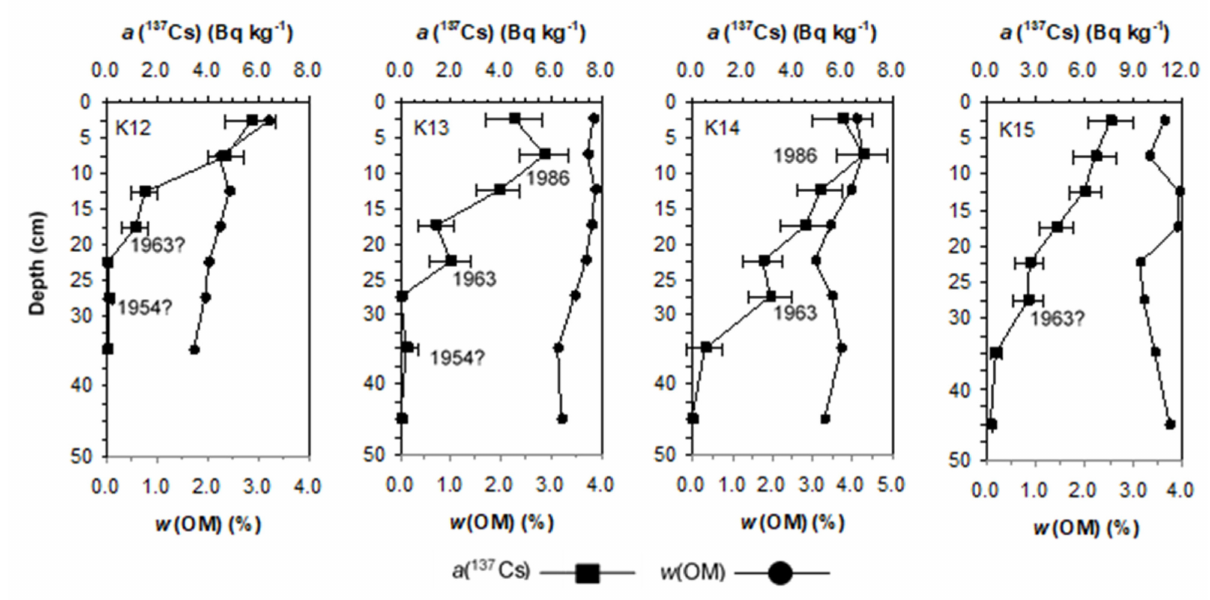
Figure 4. Profiles with (possible) 137 Cs peak representing sediment surface of 1963 and with a peak representing sediment surface of 1986, if present, and organic matter mass fraction profiles. Measurement uncertainties are expressed with k = 2 for normal distribution.